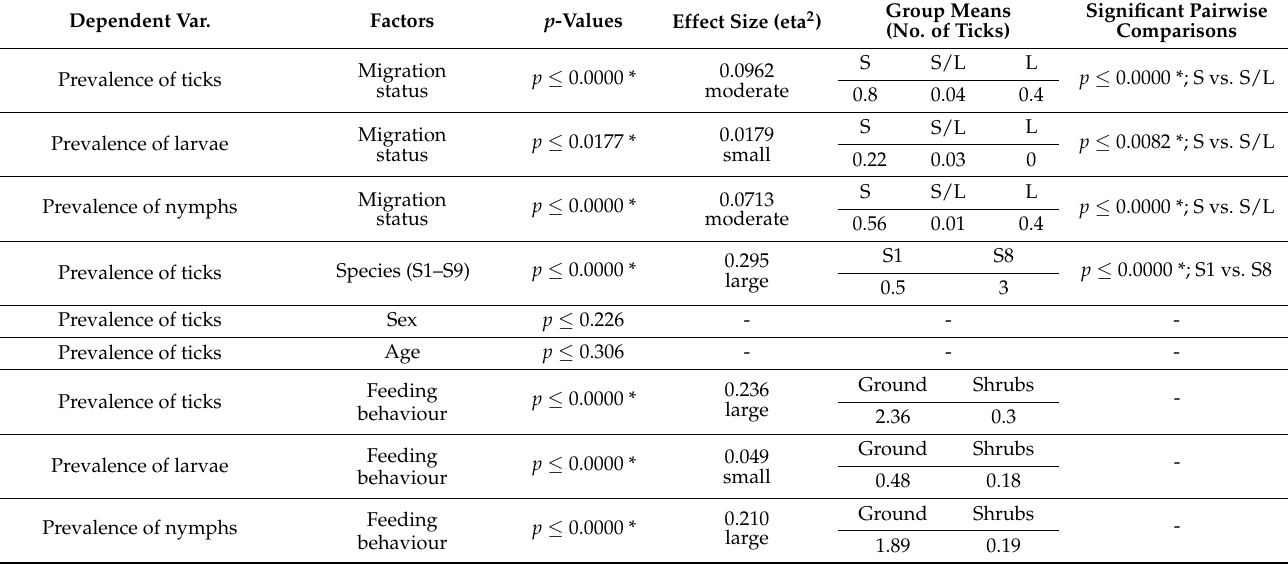
Table 2. Results of Kruskal–Wallis H tests for tick prevalence in selected bird species where at least one bird was infested with ticks.